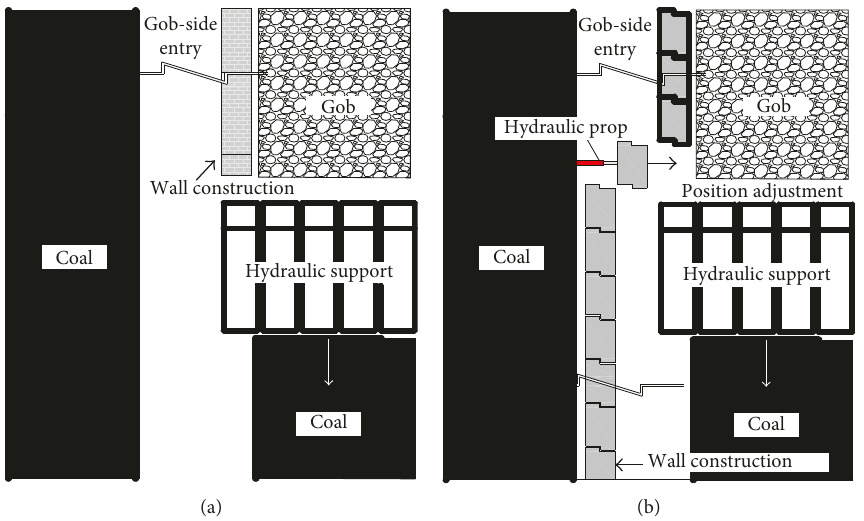
Figure 12: Approach for gob-side entry retaining: (a) conventional approach; (b) new approach.